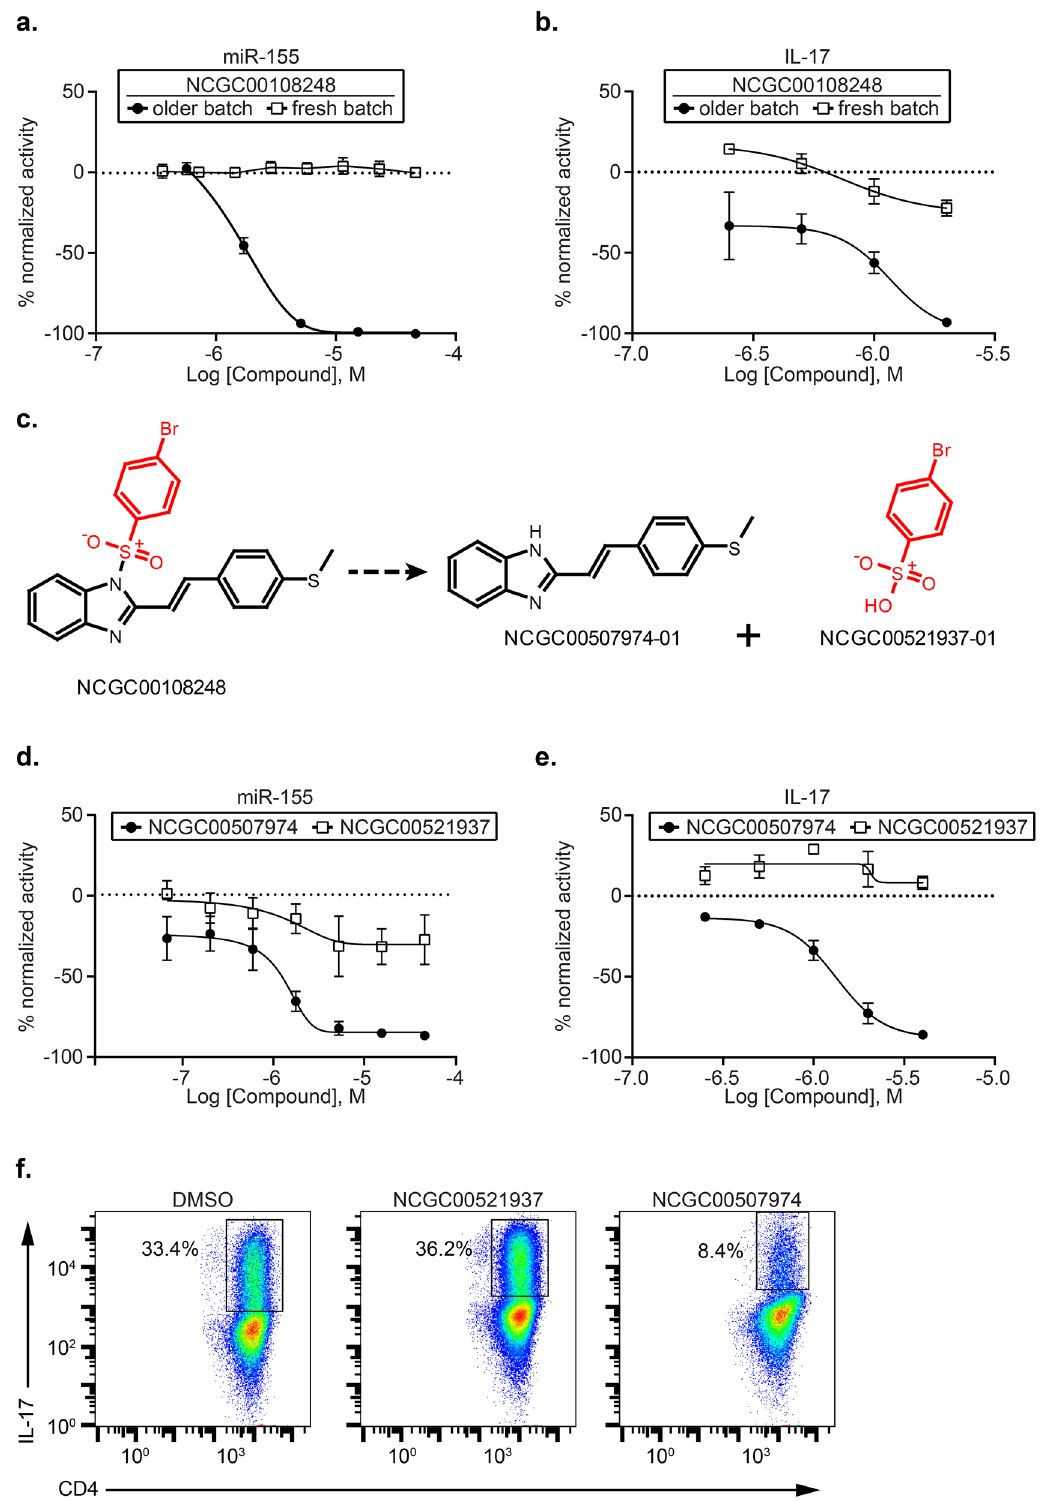
Figure 5. Identification of Active Compound of ( E )-1-(phenylsulfonyl)-2-styryl-1 H -benzo[ d ] imidazoles. Naïve CD4 + T cells from spleens and lymph nodes of Mir 155 reporter mice (HTS assay) or C57BL/6 mice (IL-17 assay) were purified and differentiated under Th17 polarization conditions. ( a ) Dose response curves for NCGC00108248 (fresh and older batches) for Mir155 reporter Beta Glo HTS assay. ( b ) Dose response curves for NCGC00108248 (fresh and older batches) in IL-17 flow cytometric cytokine assay. ( c ) NCGC00108248 ( E )-1- ((4-bromophenyl)sulfonyl)-2-(4-(methylthio)styryl)-1 H -benzo[ d ] imidazole was treated with sodium hydroxide to yield NCGC00507974. ( d ) Dose response curves for NCGC00507974 and NCGC00521937 in Mir155 Beta Glo HTS assay. ( e ) Dose response curves for NCGC00507974 and NCGC00521937 in IL-17 flow cytometric assay. ( f ) Flow cytometric plots showing DMSO, NCGC00507974 and NCGC00521937 treated cells stained for surface CD4 and intracellular IL-17. The plots are gated on live CD4 + CD44 high cells. Data are representative of 2–3 independent experiments and the error bars indicate standard